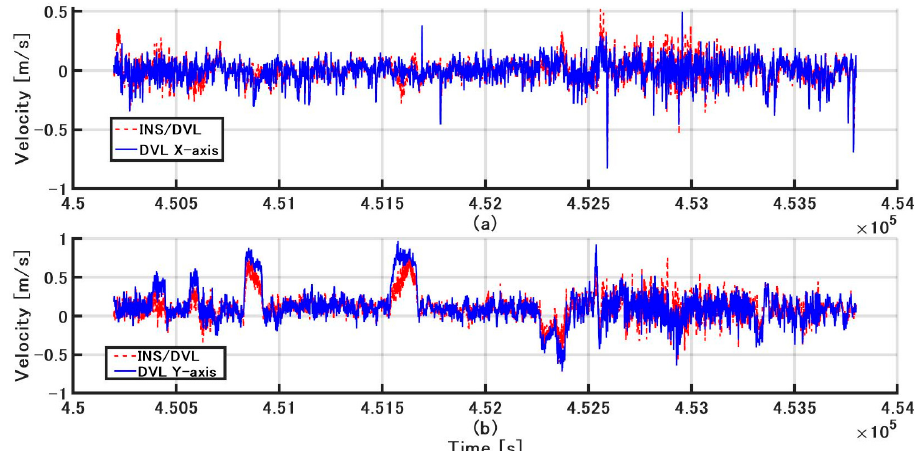
Figure 14. ( a ) INS/DVL and DVL x-axis velocities minus estimated value, respectively; ( b ) INS/DVL and DVL y-axis velocities minus estimated value, respectively.